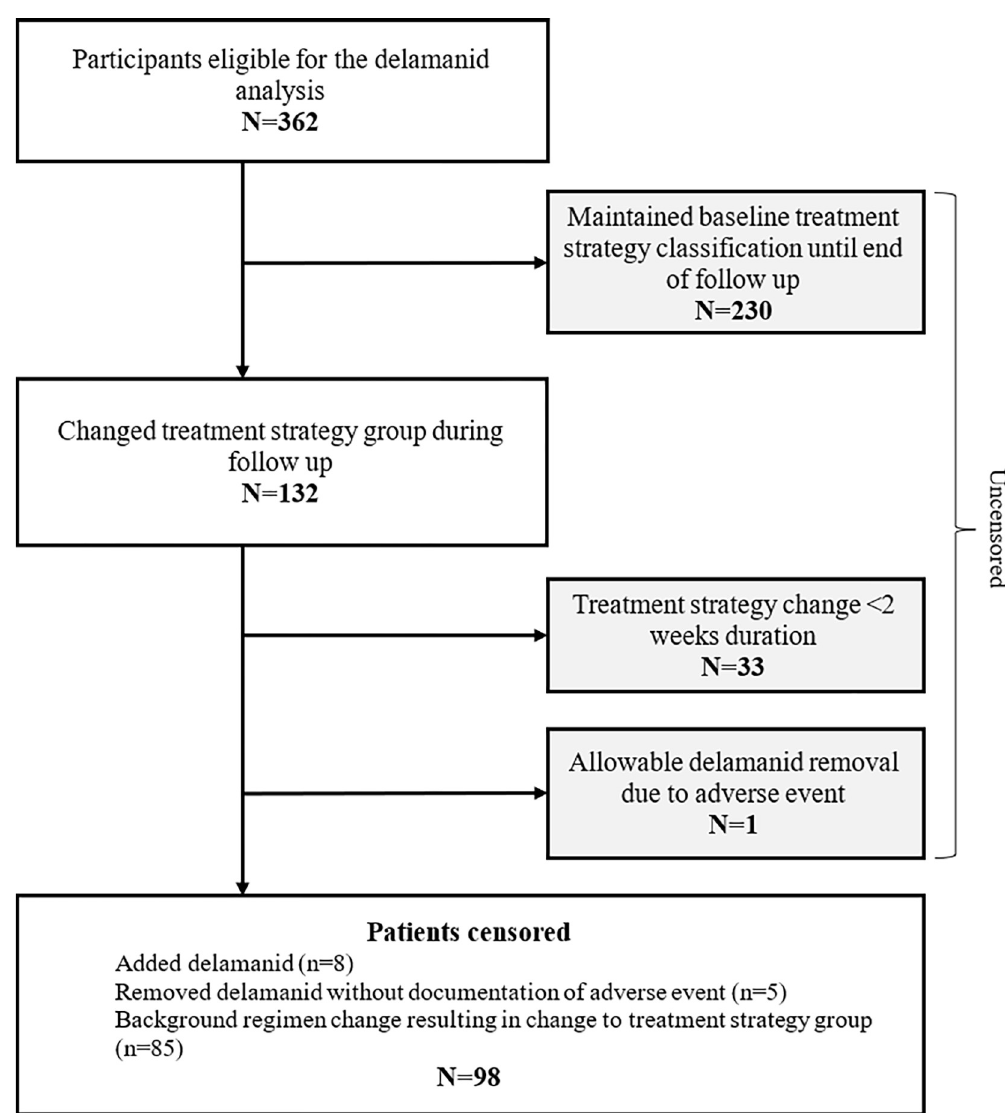
Fig 2. Flowchart of participants censored due to changing treatment strategies in the endTB observational cohort. who did not have culture conversion, 6 (4.8%) (3 deaths, 3 LTFU) participants in the delama- nid-containing group and 7 (2.9%) (2 deaths, 5 LTFU) participants in the delamanid-free group were not retained in care. In aITT analyses, the RR of culture conversion for delamanid- containing versus delamanid-free regimens was 0.90 (95% CI: 0.73, 1.11) and RD was -0.05 (95% CI: -0.16, 0.06). In the aPP analysis the RR of culture conversion for delamanid-contain- ing versus delamanid-free regimens was 0.89 (95% CI: 0.66, 1.21) and the RD was -0.06 (95% CI: -0.21, 0.11)) (Table 2). By six months, 81.3% of participants in the delamanid-containing and 88.7% of participants in the delamanid-free group experienced sputum culture conversion. Fifteen (12.2%) (7 deaths, 8 LTFU) participants in the delamanid-containing group died or were LTFU before conversion versus 14 (5.9%) (4 deaths, 10 LTFU) in the delamanid-free group. In aITT